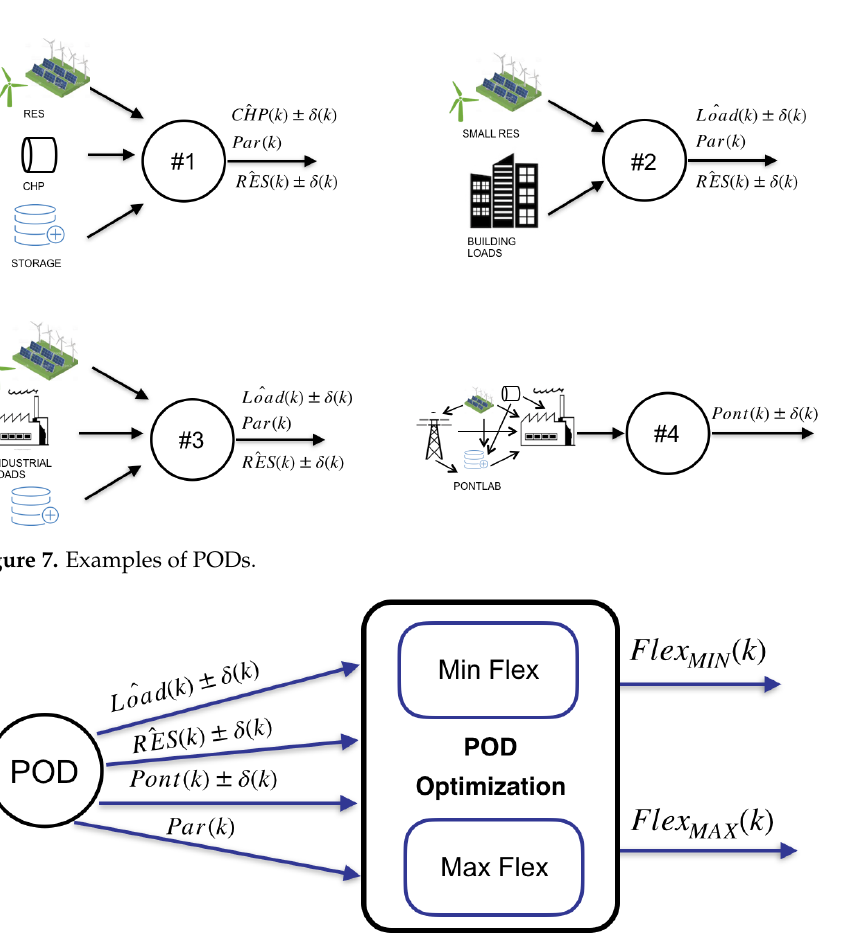
Figure 8. Local POD